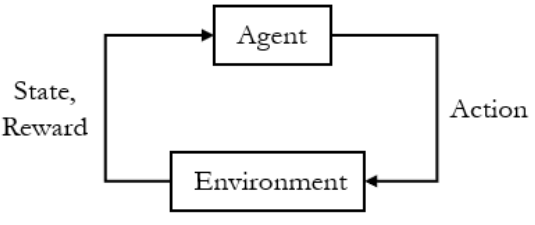
Figure 1. Diagram of a reinforcement leaning system.